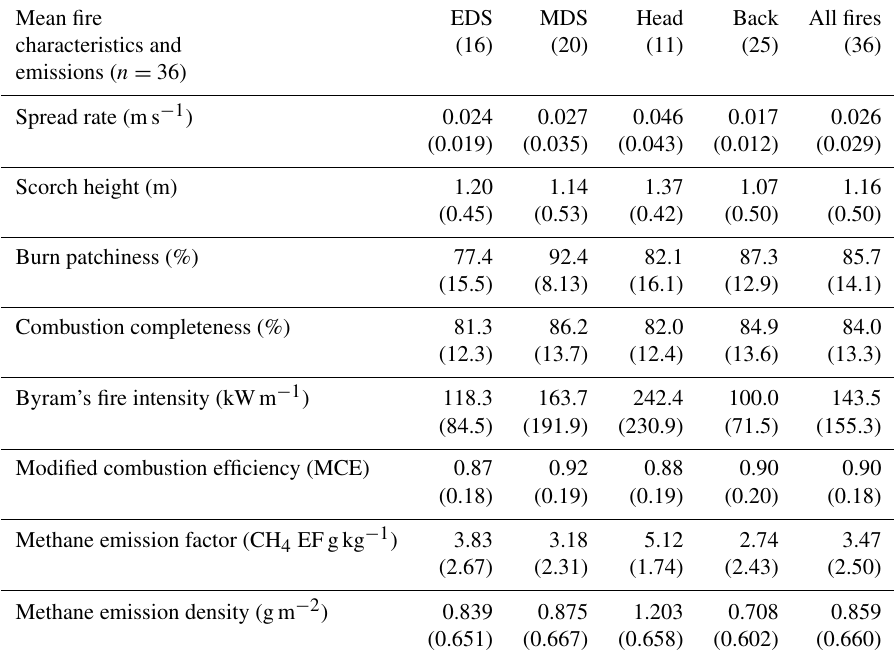
Table 2. Mean fire characteristics and emissions by study period and fire type (2014–2016, Mali). Mean